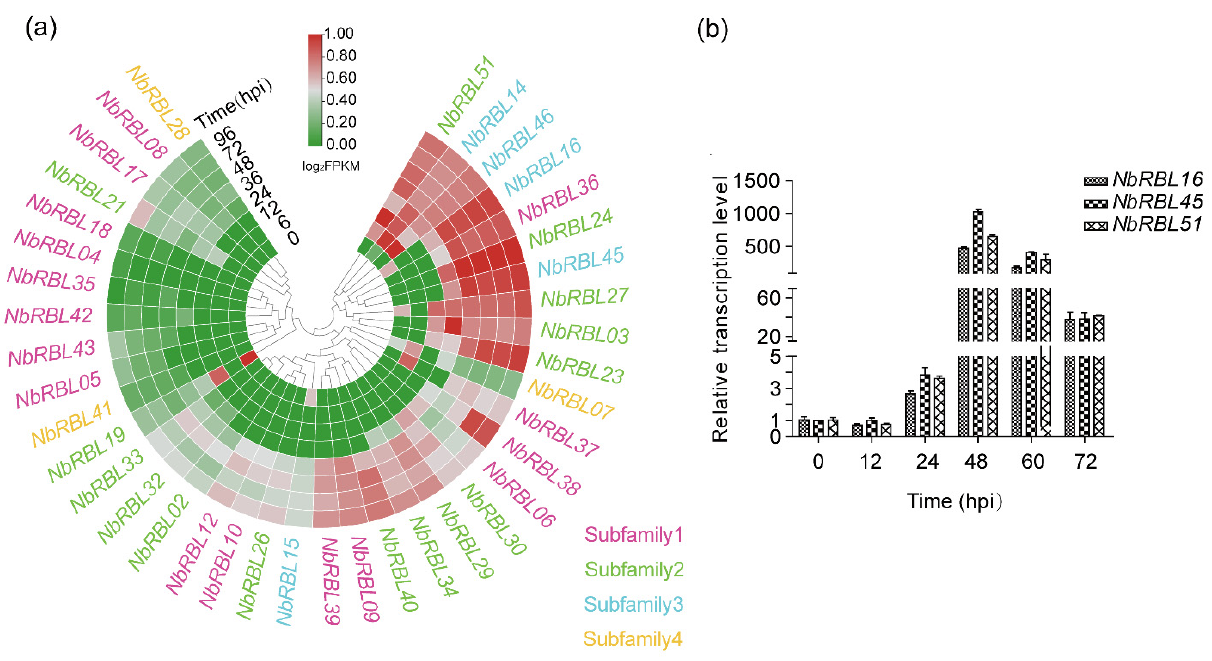
Figure 6. Expression of the Nbrbls in the BmE-SWU1 cells infected with N. bombycis . ( a ) RNA-seq analysis of Nbrbl s expression in N. bombycis - infected the BmE-SWU1 cells. Each column represents a time-point, each row represents a gene. The quantification of Nbrbl expressions was shown in Table S2. ( b ) RT-PCR examination of expression profiles of the Nbrbls in BmE-SWU1 infected with N. bombycis .